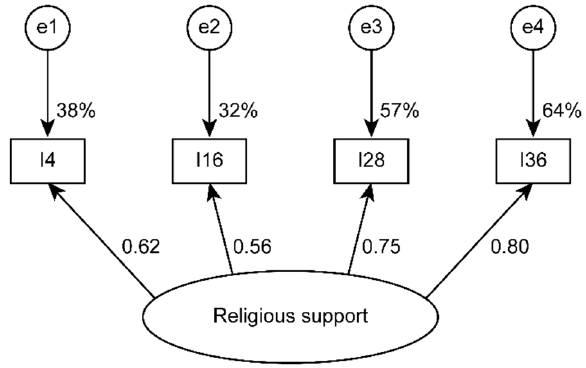
Figure 2. Single-factor model for religious support estimated using subsample B ( n = 317).